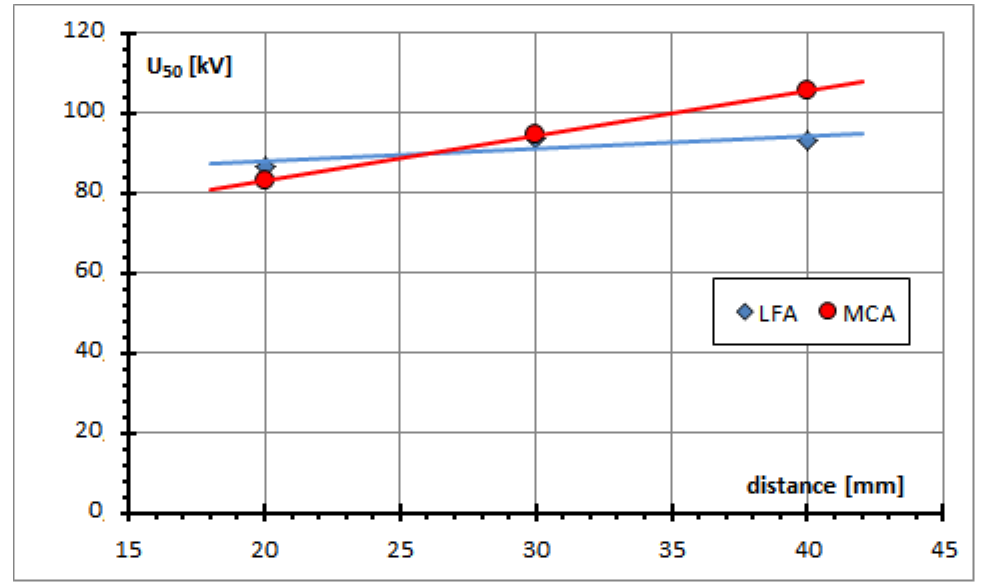
Figure 14. Comparative characteristics of 50% breakdown discharge voltage for the MCA and the LFA for negative impulse polarity.